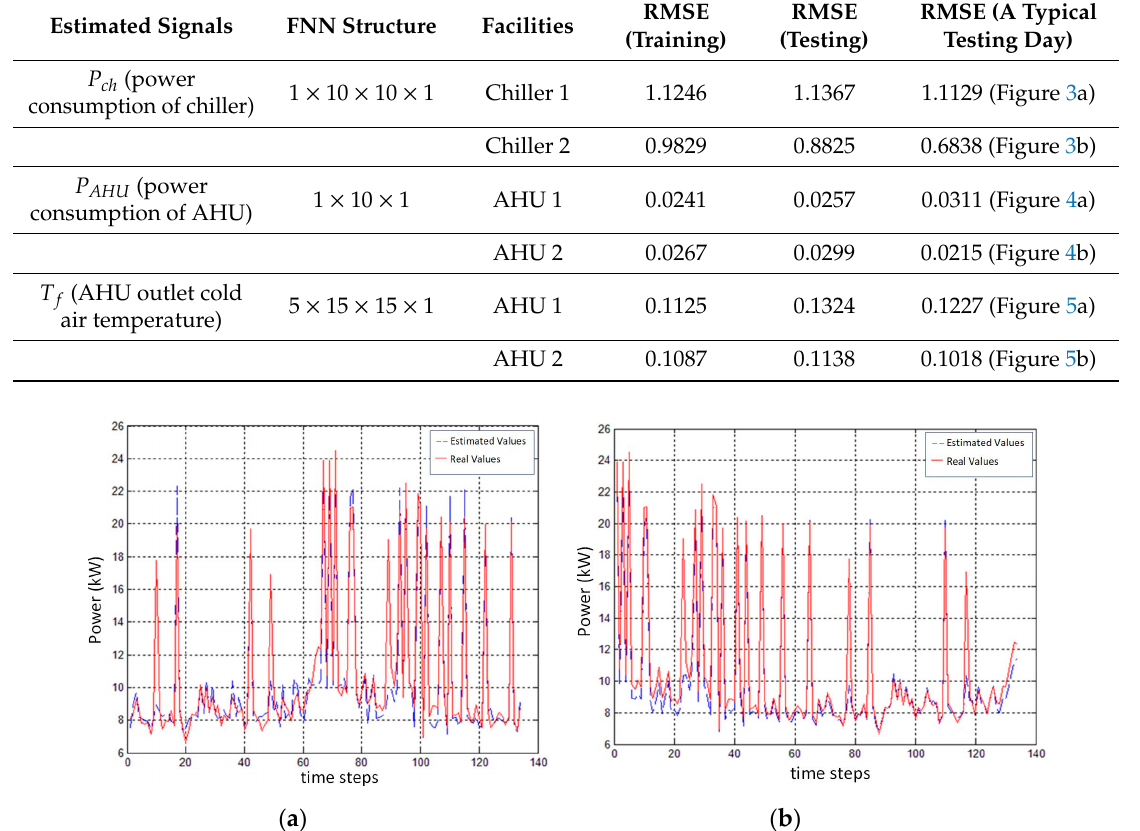
Figure 3. Comparison of chiller power consumptions between estimated and real values for ( a ) chiller 1; ( b ) chiller 2.